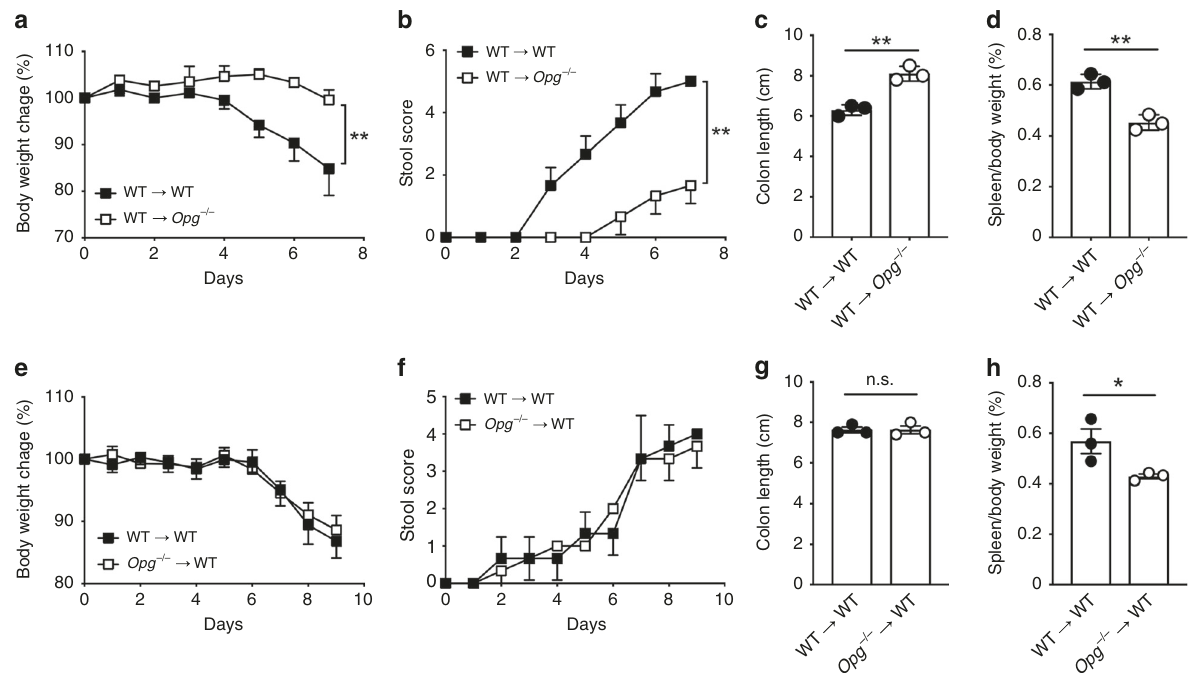
Fig. 7 Non-hematopoietic cells in Opg − / − mice contribute to relief of DSS colitis symptoms. a , e Daily changes in body weight during dextran sodium sulfate (DSS)-induced colitis. Changes in body weight percentage were calculated by dividing the body weight on the speci fi ed day by the body weight at day 0. b , f Fecal clinical scores were measured as described in the Methods. c , g Colon length was measured after sacri fi ce at day 8. d , h Spleen weight was measured after sacri fi ce at day 8. WT or Opg − / − recipient mice following bone marrow transplantation from WT donors ( a – d ) and WT recipient mice following bone marrow transplantation from WT or Opg − / − donors ( e – h ) treated with 1.5% DSS for 7 days. Data are representative of two independent experiments. ** p < 0.01, n.s. not signi fi cant, p values were calculated using unpaired t -test ( n = 3 mice). The source data underlying panels a – h are provided as a Source Data fi